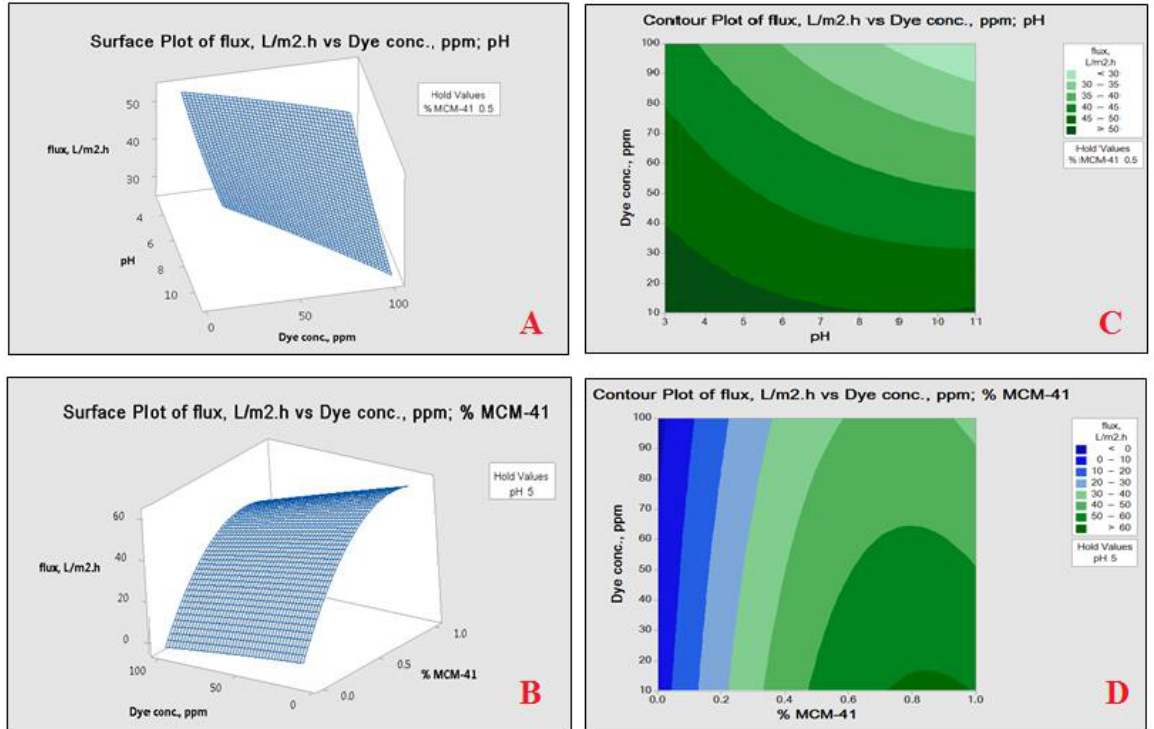
Figure 7. Three-dimensional response surface plot ( A , B ), and two-dimensional response contour plot ( C , D ) of the permeability as a function of the MCM-41 weight ratio, feed pH, and dye concentration for RB dye.